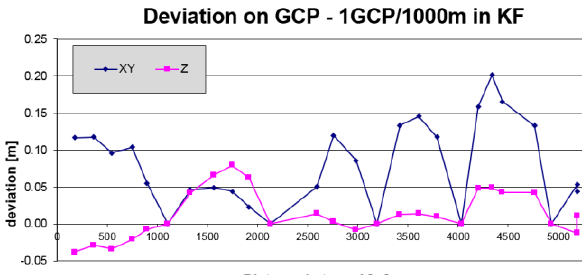
Figure 5: Deviation on GCPs using GCPS every 1000m for